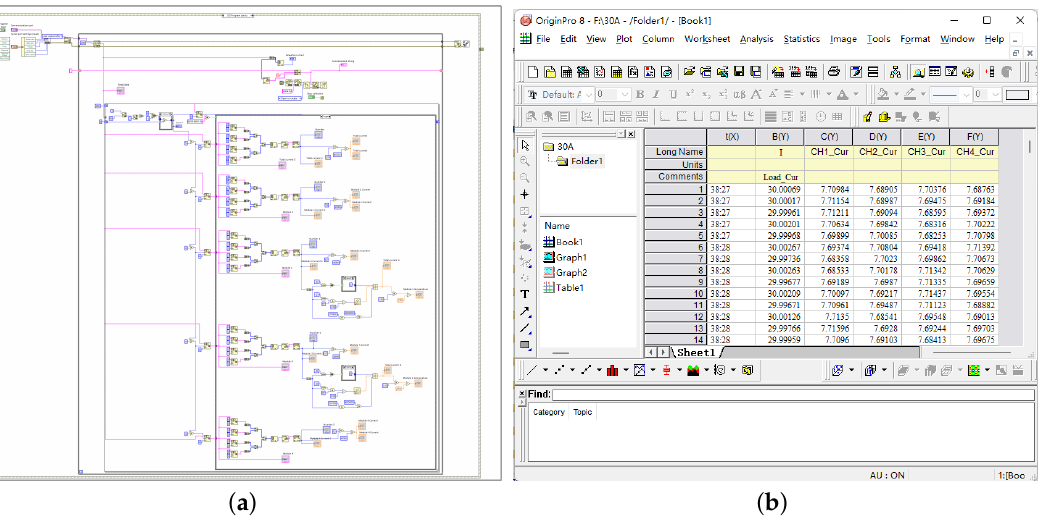
Figure 21. Screenshots of the software platform. ( a ) The sampling and display program based on the software LabVIEW; ( b ) Data processing based on the software